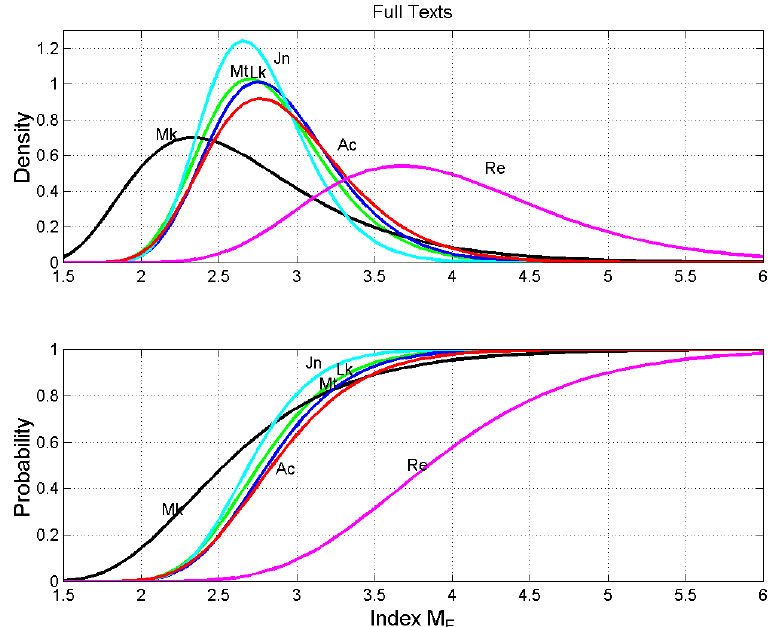
Figure 3. Probability density functions (upper panel) and probability distribution functions (lower panel) of the number of interpunctions per sentence M F . Matthew : green line; Mark: black line; Luke : blue line; John : cyan line; Acts : red line; Revelation : magenta line. Table 9. Full Texts. Kolmogorov–Smirnov test results for I P (below the diagonal of zeros) and M F (above the diagonal). The values reported are the confidence level (%) that the indicated couple of probability distributions are not